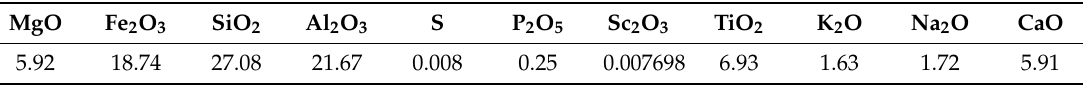
Table 1. Main chemical composition analysis results of scandium rough concentrate (wt %).